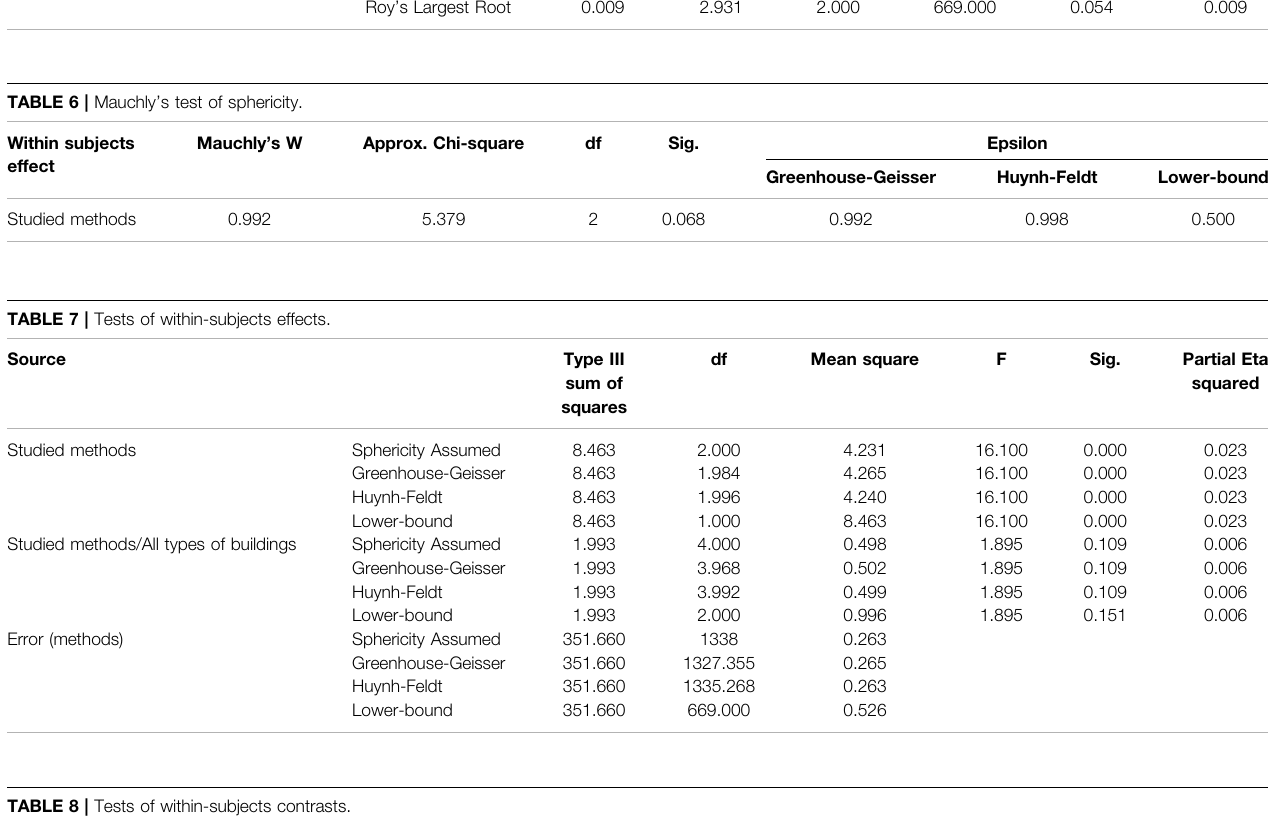
TABLE 8 | Tests of within-subjects